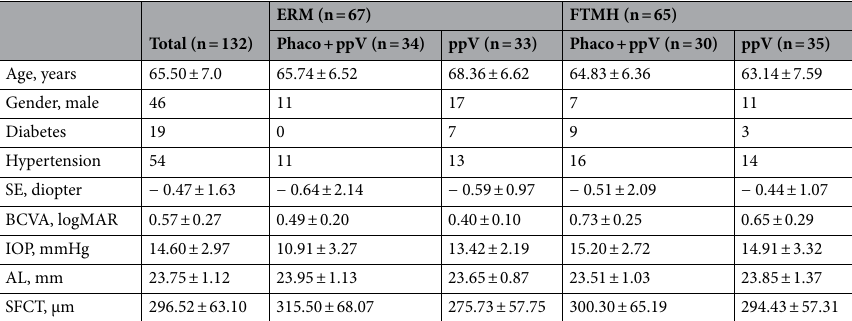
Table 1. Demographic and clinical characteristics of the study participants at baseline. Data are expressed as mean ± standard deviation (95% confidence interval). Abbreviations: AL, axial length; BCVA, best-corrected visual acuity; ERM, epiretinal membrane; FTMH, full thickness macular hole; IOP, intraocular pressure; logMAR, logarithm of the minimum angle of resolution; Phaco, phacoemulsification; ppV, pars plana vitrectomy; SE, spherical equivalent; SFCT, subfoveal choroidal